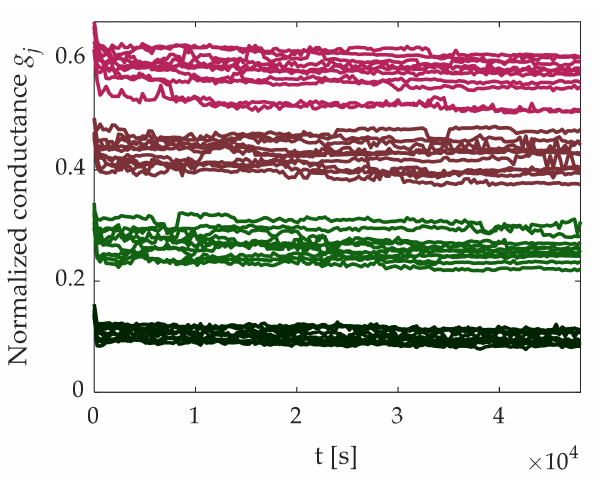
Figure 18. Programmed cell conductance behavior monitored for 14 h. Only 10 cells for each group are plotted. Initial normalized conductance target values were 1/6, 1/3, 1/2, and